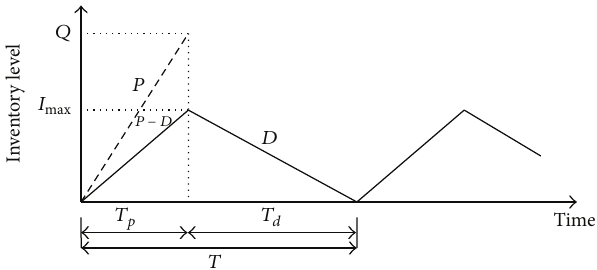
Figure 2: The relation between inventory level and time.